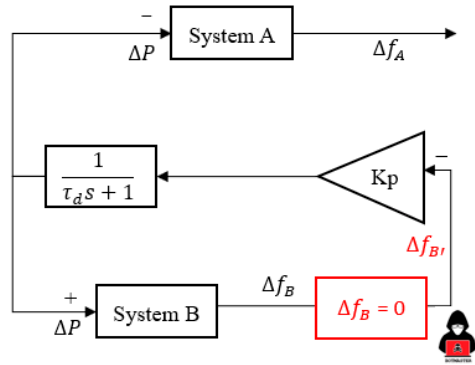
Figure 9. Missing data attack in terms of E-FCR operation.